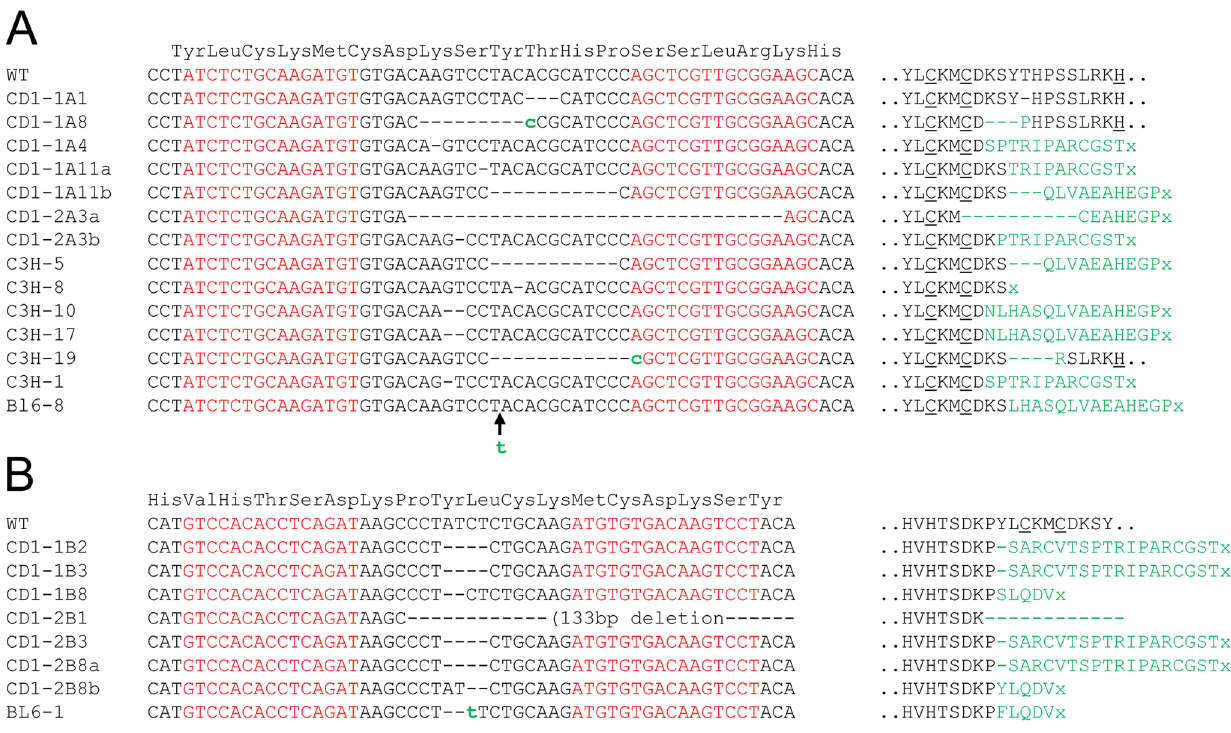
Figure 2. Sequence information of Zic2 mutant alleles. A) Sequences obtained from the mutant blastocysts (CD1) or from the founder lines of mutant mice (C3H and C57BL/6J) generated following microinjection of TALEN-A mRNAs. B) Sequences obtained from the mutant blastocysts (CD1) or from the founder line of mutant mice (C57BL/6J) generated following microinjection of TALEN-B mRNAs. The DNA sequences to which the TALEN monomers were designed are highlighted in red. Nucleotide mutations and insertions (shown with arrows) are shown in lower case and are highlighted in green. The reading frame of the ZIC2 protein is shown above the wild-type sequences and the predicted consequences of the mutation on the amino acid sequences are shown to the right of the DNA sequences. Divergence (missense/deletion etc) from the wild-type peptide sequence is shown in green and premature Stop codons are shown as x. Critical cysteine and histidine residues of the 5 th zinc finger domain are underlined.